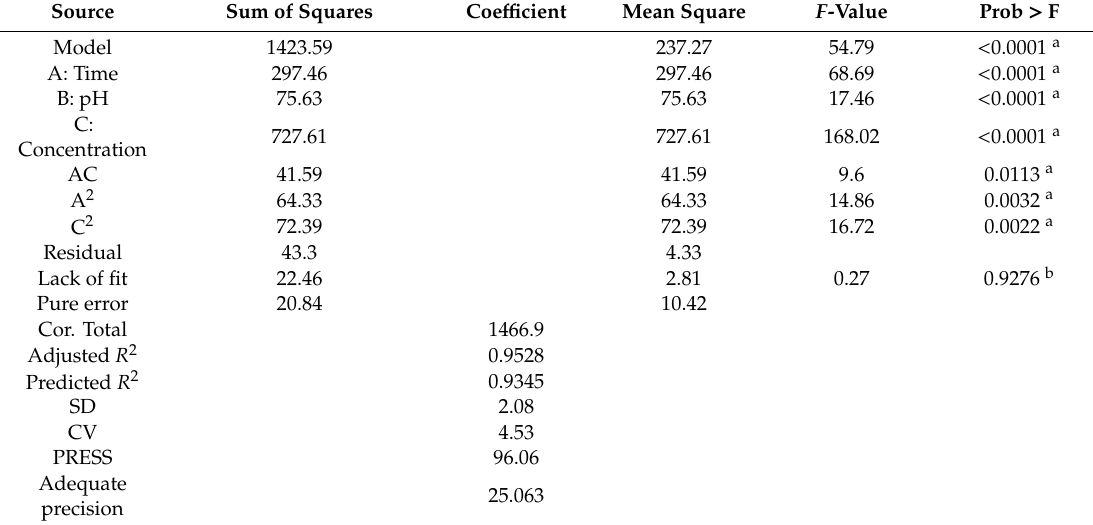
Table 3. ANOVA for response surface reduced quadratic